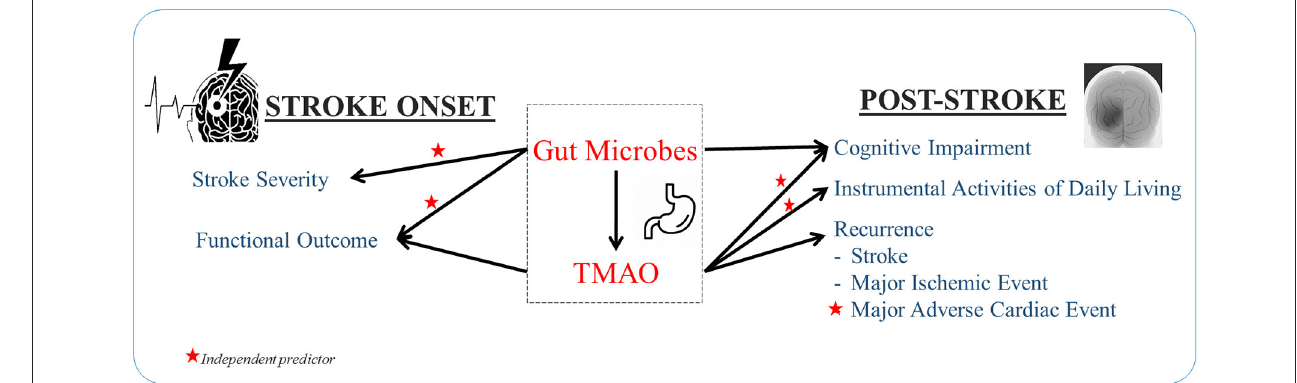
FIGURE 2 | Gut dysbiosis and plasma TMAO independently predict stroke